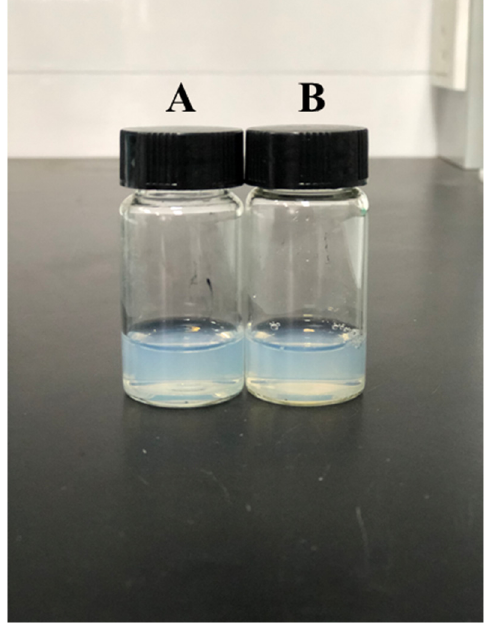
Figure 2. Appearance of blank S/T-MM ( A ) and PPD-S/T-MM-2.0 ( B ).